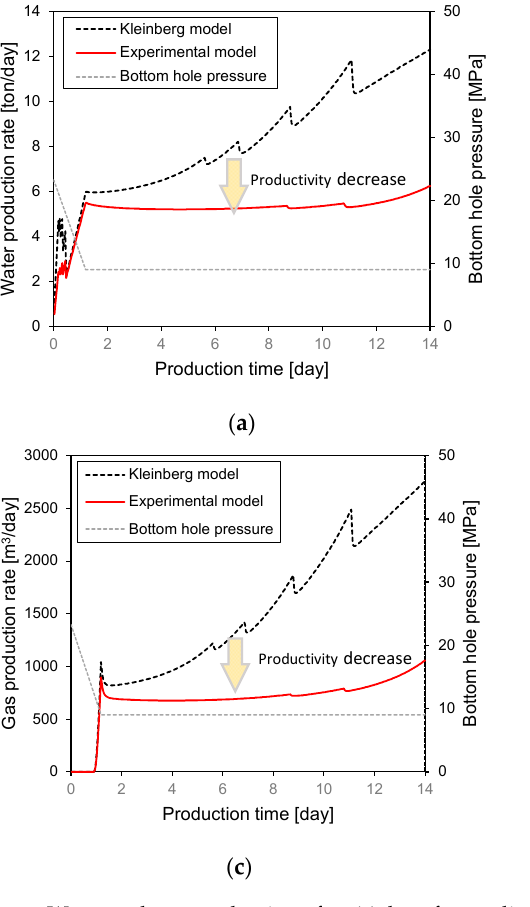
Figure 8. Water and gas production after 14 days for studied permeability models: ( a ) water production rate; ( b ) cumulative water production; ( c ) gas production rate; ( d ) cumulative gas production.